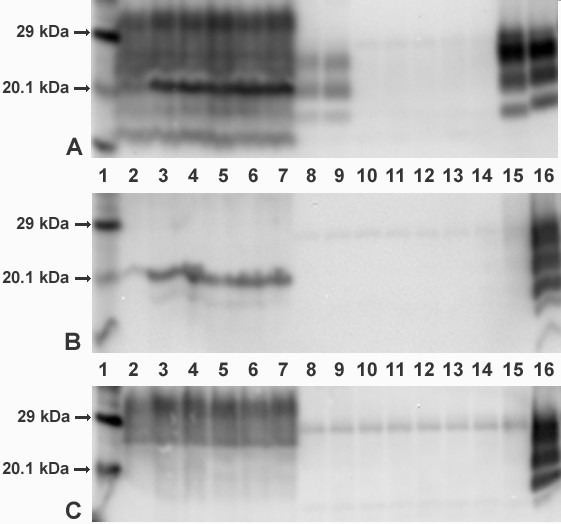
Western immunoblot of caudal medulla of selected pigs from each group.Lanes1      Biotinylated molecular mass markerNo PK   PK+   Animal ID2         8      BSE group (positive) - PR4633         9      BSE group (positive) - PR4434         11     Pre-1996 group (negative) - PR4695         12     Post-1996 group (negative) - PR4766         13     BSE group (negative, clinical suspect) - PR4427         14     Un-inoculated pig (negative) - PR459          10     NZ-brain (negative) - PR591          15     Bovine BSE positive control          16     Ovine scrapie positive controlVLA Hybrid technique (discriminatory WB) using core mAb, 6H4 (Figure A), and 'N' terminal mAbs, P4 (Figure B) and 12B2 (Figure C), to distinguish scrapie from BSE. Treatment with and without PK was used to visualise PrPres and PrPc respectively.